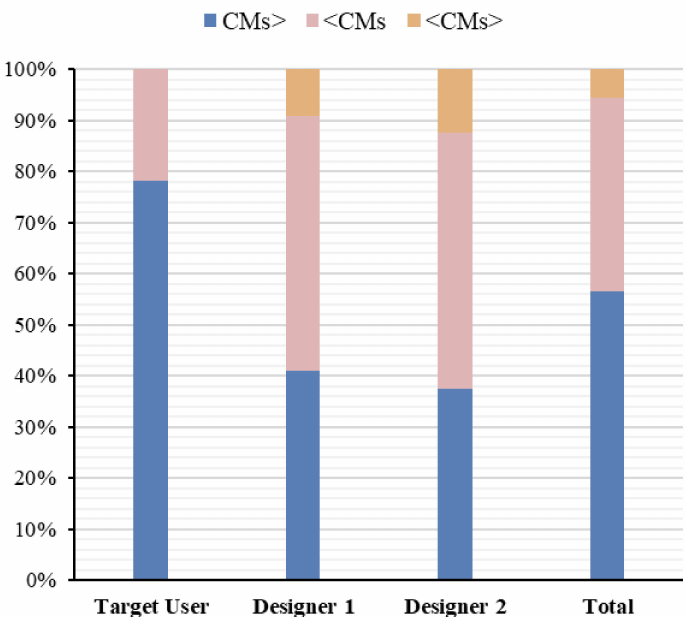
Figure 4. The ratios of various CMs generated by each collaborator during the co-design